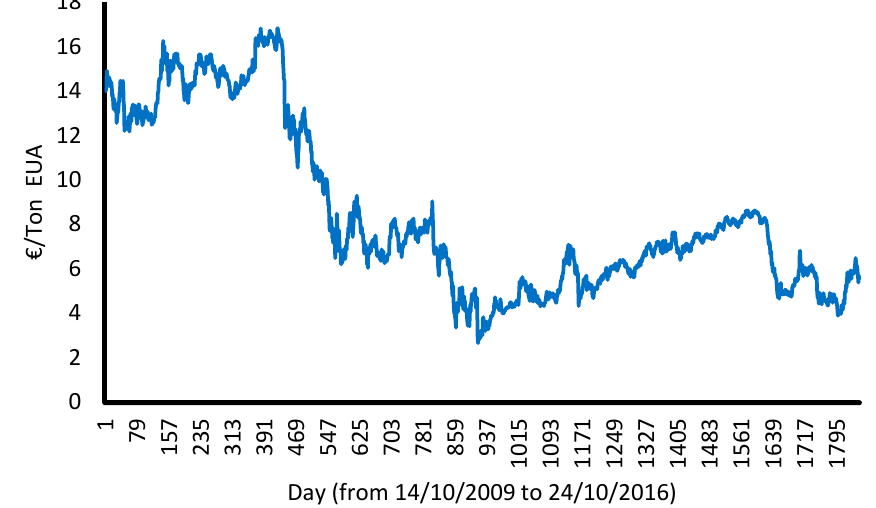
Figure 1. Time evolution of EUA prices (October 2009–October 2016). Table 1. Variables analyzed to determine the influence of energy or raw materials on the forecasting accuracy of prices of CO 2 emission allowances.